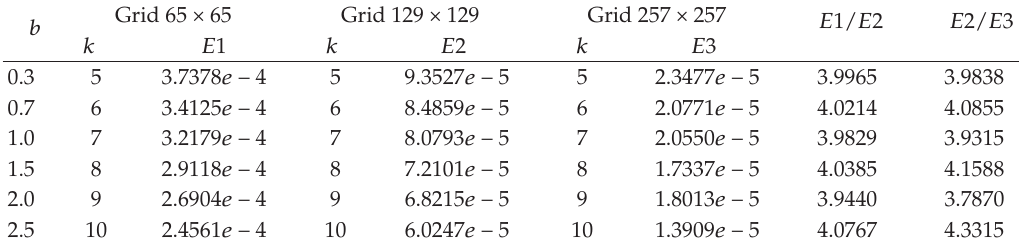
Table 1: Convergence of the method in Example 4.3 for a (cid:10)